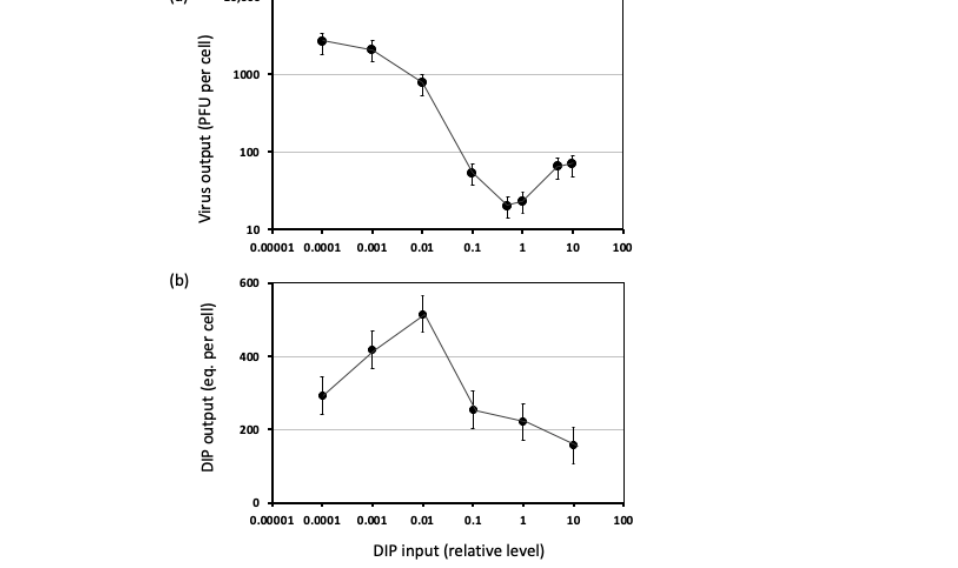
Figure 4. Production of ( a ) standard virus and ( b ) DI particles by co-infected cells is a complex function of DI particle inputs. All cells were co-infected with standard virus (MOI 20) and different input levels of DI particles. Levels of standard virus and DI particles were determined by plaque assay and plaque-reduction assay; adapted from [104].